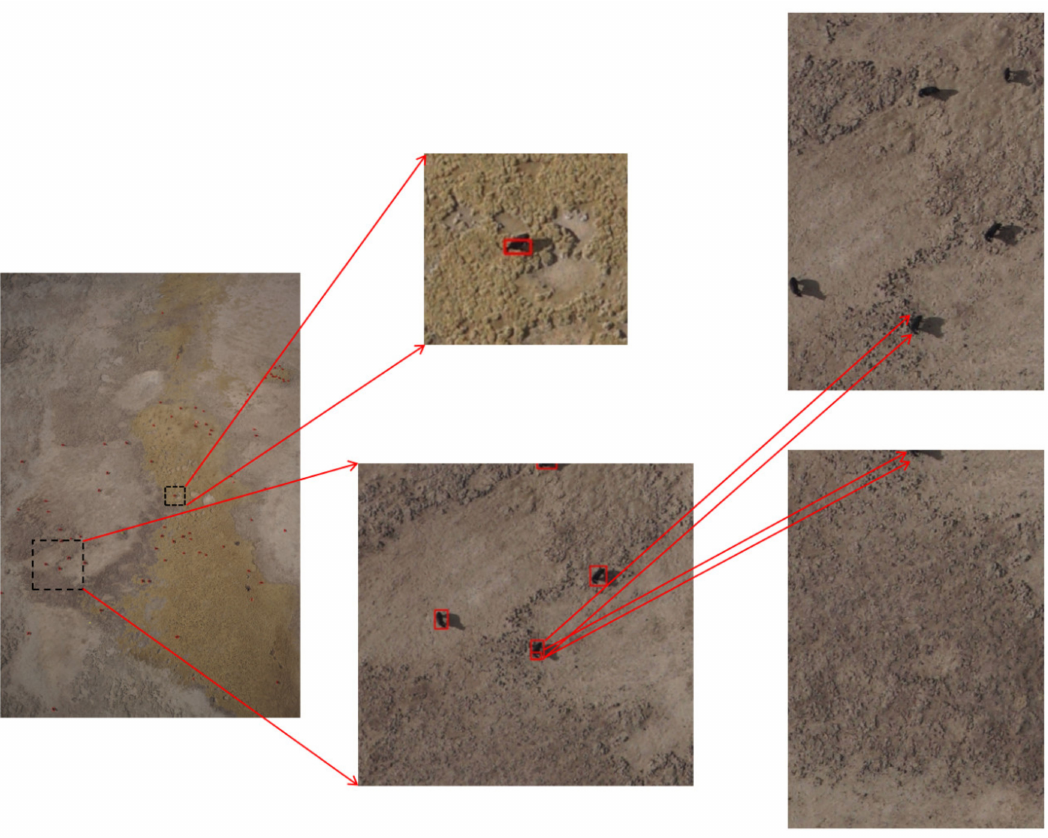
Figure 16. Result diagram of detection performed using original overlapping segmentation (the red boxes in the figure are the detection result boxes detected by the improved Faster-RCNN model using the original overlapping segmentation method).